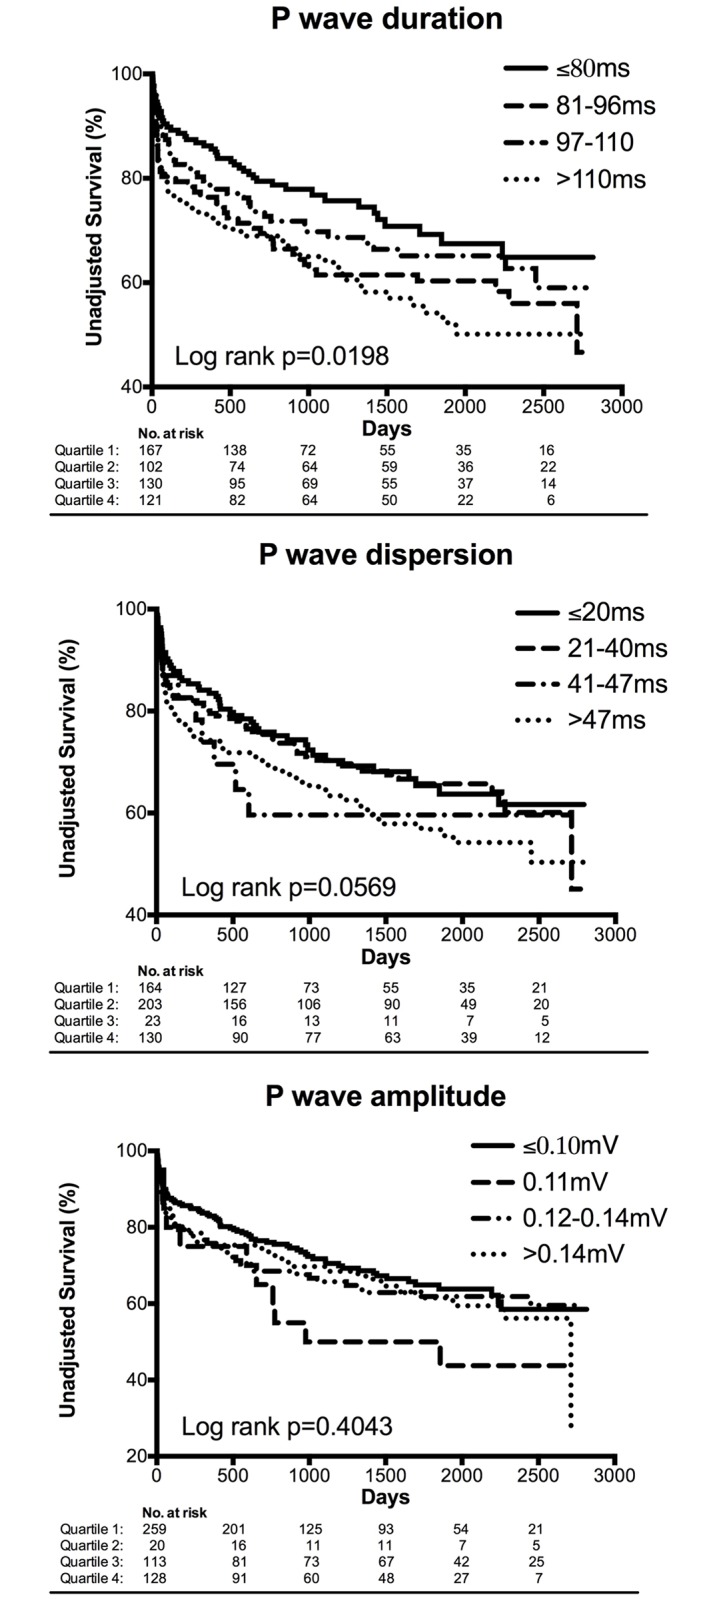
Kaplan-Meier curves for all-cause mortality, according to the P-wave indices (quartiles).